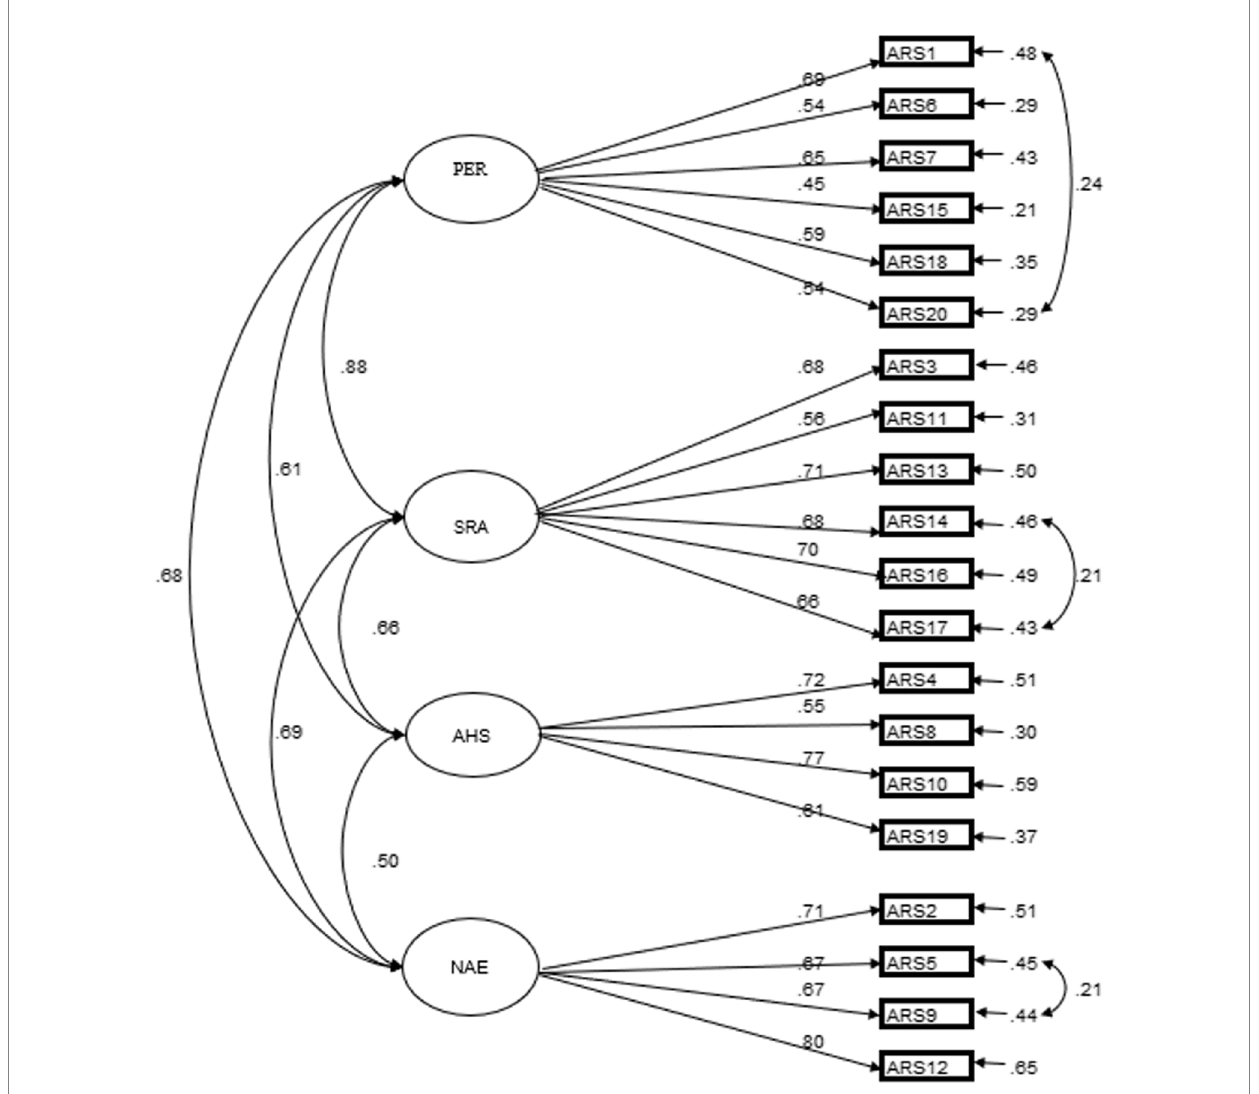
FIGURE 1 First-order Model Structure of ARS-MCV. PER = Perseverance; SRA = Self-reflection and adaption; AHS = Adaptive help-seeking; NAE = Negative affect and emotional response (reversed Scoring). All modeled correlations and path coefficients are standardized and significant at p <